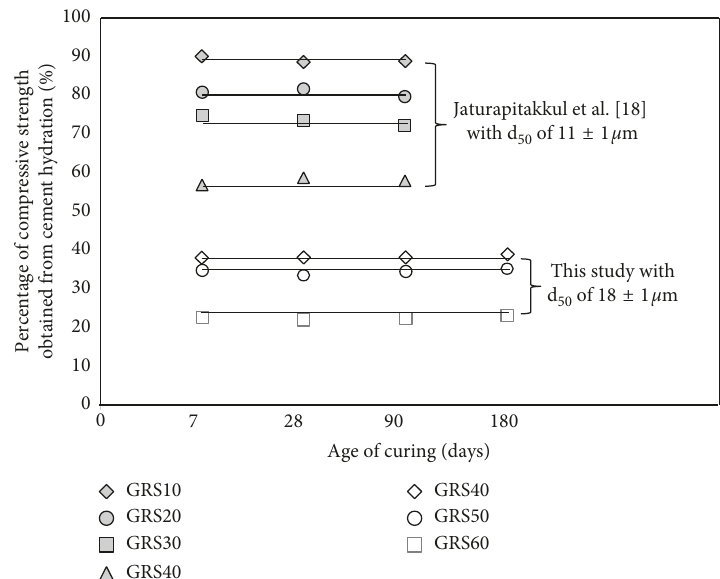
Figure 6: Relationship between percentage of compressive strength of GRS mortar and age of Table 6: Compressive strengths of mortars containing GGBF slag. Mixtures